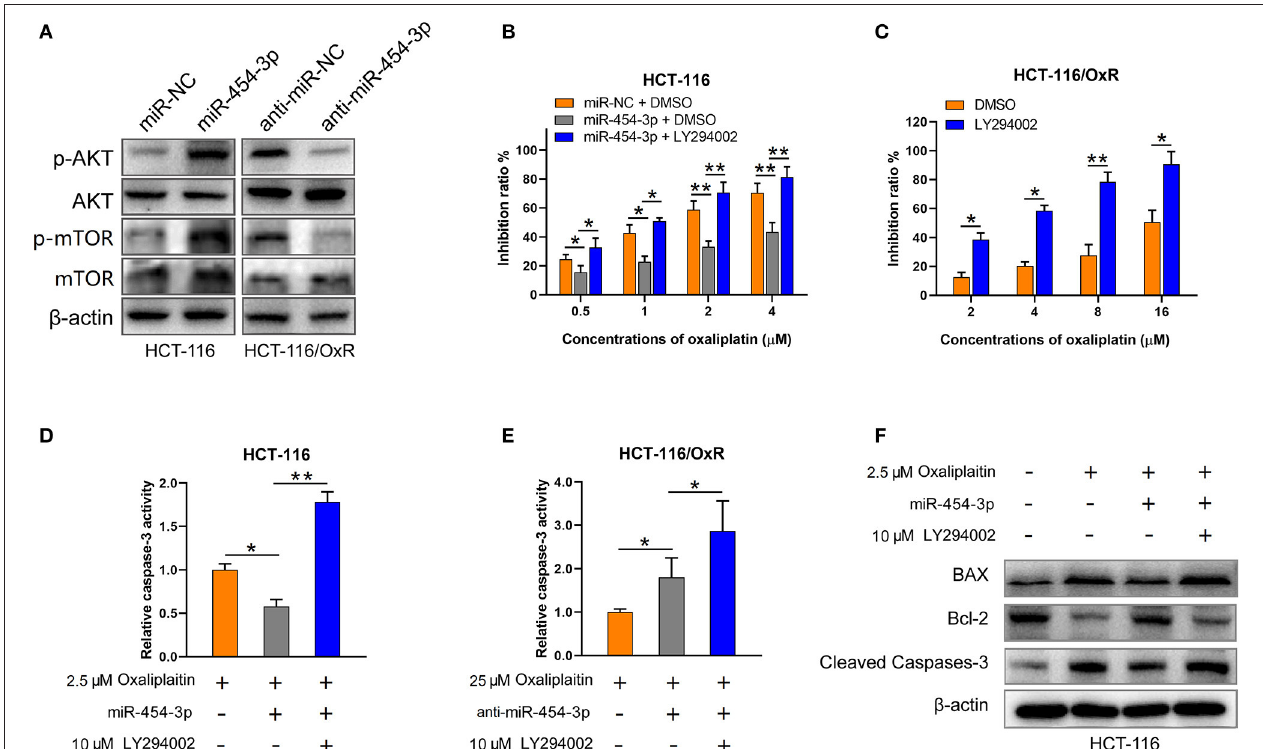
FIGURE 5 | MiR-454-3p suppressed apoptosis and induced oxaliplatin resistance via activation of AKT pathway. (A) Western blotting on the expression of p-AKT, p-mTOR, total AKT, and total mTOR. β -Actin was used as an endogenous reference. (B,C) Cell viability determined by MTT assay in indicated cells treated with oxaliplatin and/or AKT signaling inhibitor LY294002. (D,E) Caspase-3 activity in indicated cells treated with different concentrations of oxaliplatin and/or LY294002. (F) Western blotting on the expression of apoptosis-related proteins, including Bax, Bcl-2, and cleaved caspase-3. Results were presented as mean ± SD from three independent experiments. * P < 0.05, ** P <